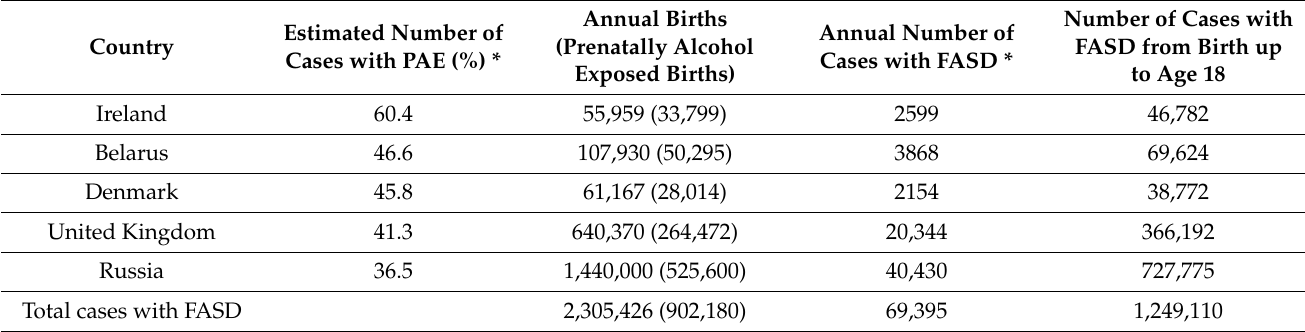
Table 3. Estimated annual number of cases of FASD in the five countries (Ireland, Belarus, Denmark, the United Kingdom, and Russia) reporting the highest prevalence of alcohol use during pregnancy in the world in